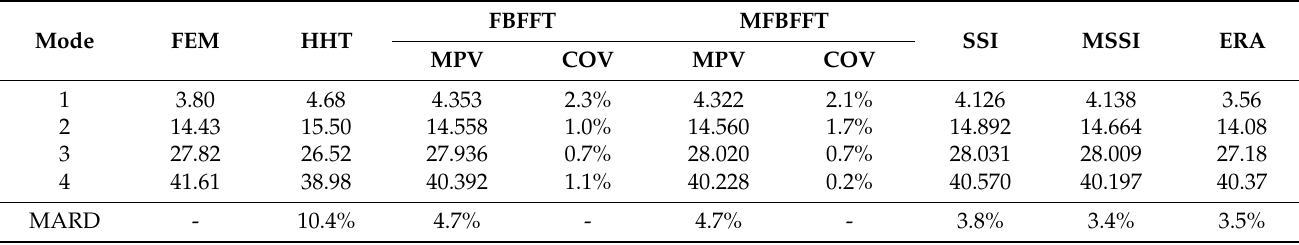
Table 4. Identified results of the natural frequencies (Hz) for the shaking table test.